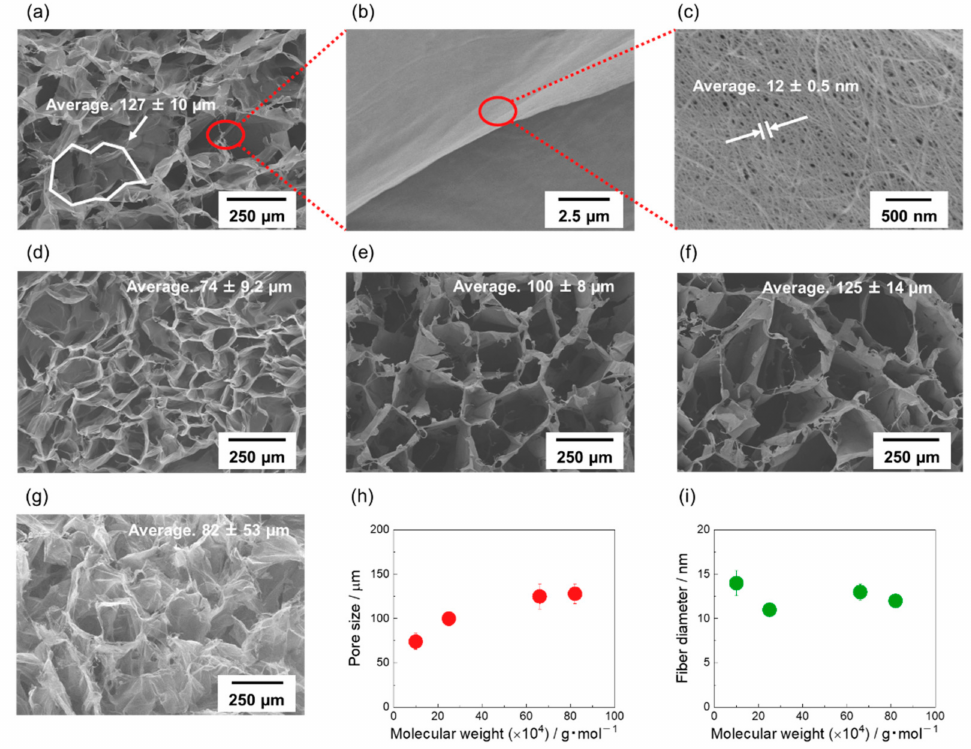
Figure 4. ( a ) SEM image of top surface of CNT/CMC4(1.3_10). ( b ) SEM image of the sheet structure forming the skeleton of CNT/CMC4(1.3_10). ( c ) SEM image of the sheet surface of CNT/CMC4(1.3_10) in magnitude. ( d ) SEM image of top surface of CNT/CMC1(1.3_10). ( e ) SEM image of top surface of CNT/CMC2(1.3_10). ( f ) SEM image of top surface of CNT/CMC3(1.3_10). ( g ) SEM image of top surface of CNT/CMC1(1.3_20). ( h ) Relationship between weight average molec- ular weight of CMC and average pore size and ( i ) relationship between weight average molecular weight and average diameter of CNT fiber bundles in CNT/CMC